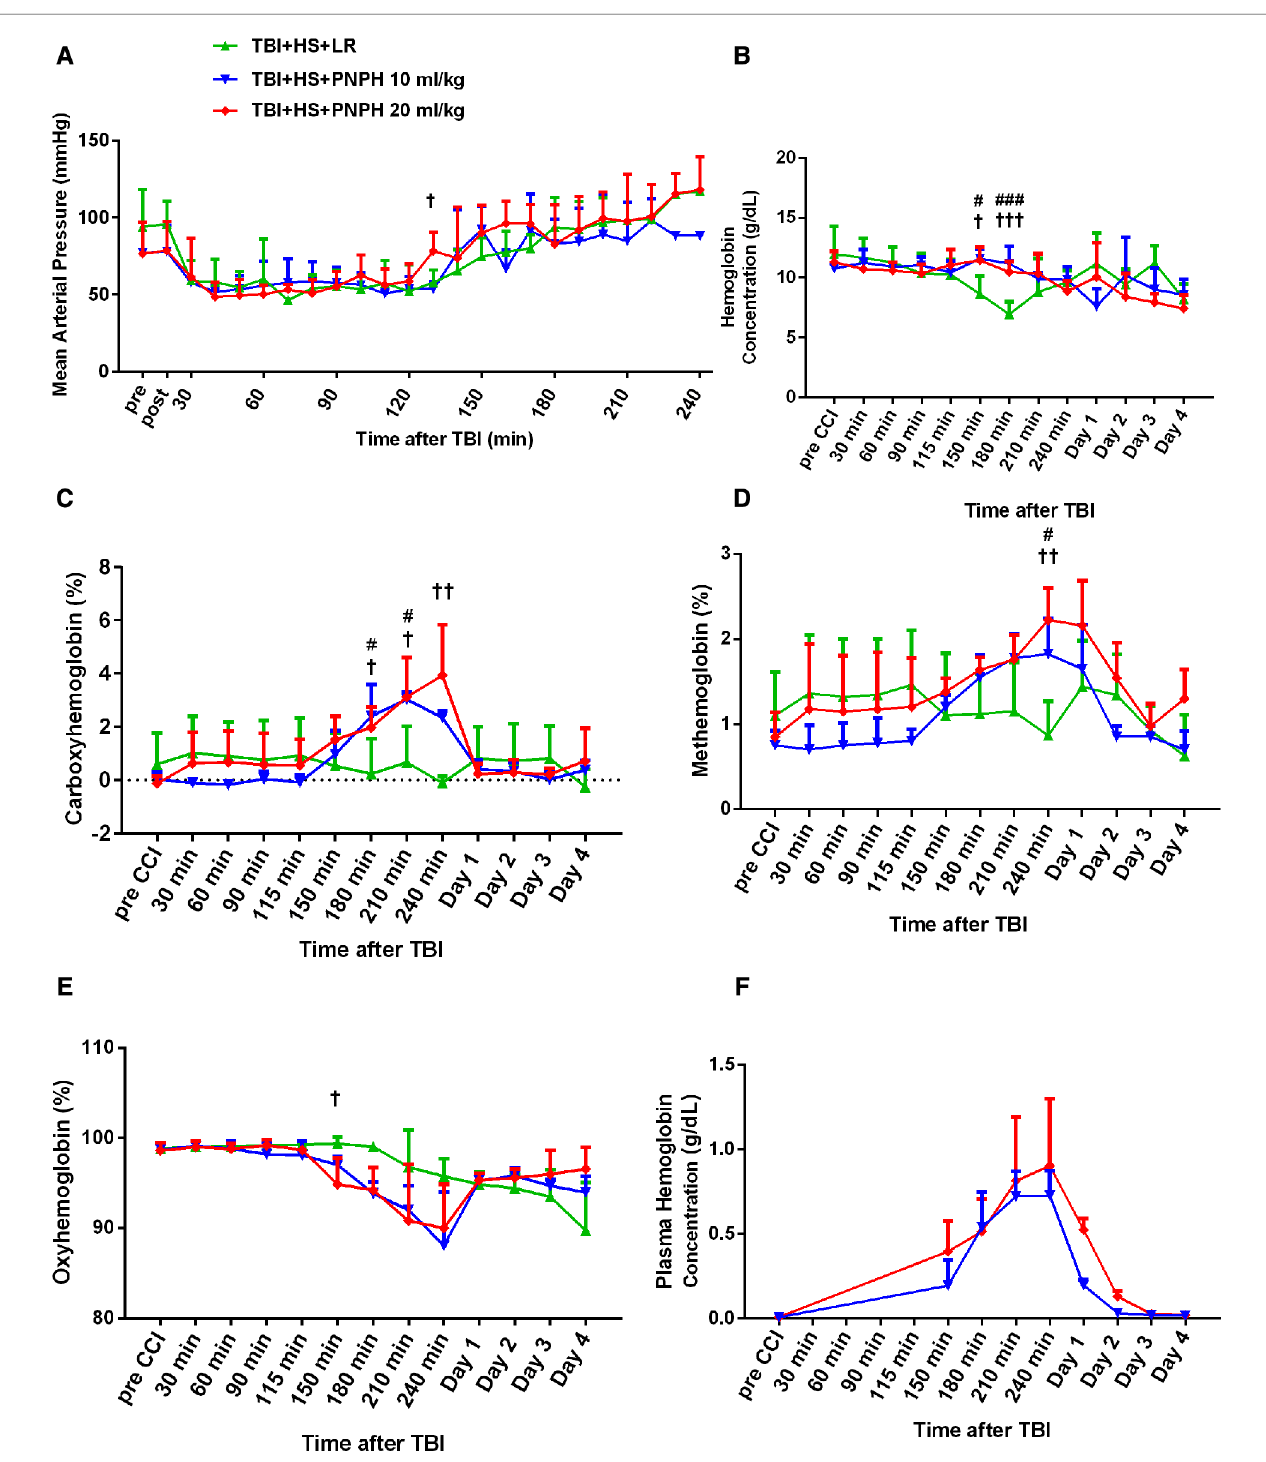
FIGURE 2 Time course of mean arterial pressure ( A ), hemoglobin concentration ( B ), percent of carboxyhemoglobin ( C ), percent of methemoglobin ( D ), and percent of oxygenated hemoglobin ( E ) in whole blood for groups of pigs subjected to TBI and 120 min of hemorrhagic shock (HS) followed by infusion of 60 ml/kg lactated Ringer ’ s (LR) solution, 10 ml/kg PNPH, or 20 ml/kg PNPH. Sample sizes per time point were 3 – 5 for LR group, 3 – 4 for 10 ml/kg PNPH group, and 4 – 5 for 20 ml/kg PNPH group (smaller sample sizes occurred at 180 – 240 min when arterial blood samples could no longer be drawn because the pig was too active or the subcutaneously-routed catheter was inoperable). Individual data are shown in Supplemental Figures 1 – 5 . PNPH infusion produced increases in plasma hemoglobin concentration that subsided over 1 – 2 days ( F ). Values are means±SD. # P <0.05, ### P <0.001 TBI+HS+LR vs. TBI+HS +10 ml/kg PNPH; † P <0.05, †† P <0.01 TBI+HS+LR vs. TBI+HS+20 ml/kg PNPH. Signi fi cance determined by one-way ANOVA and the Holm-Sidak procedure for multiple